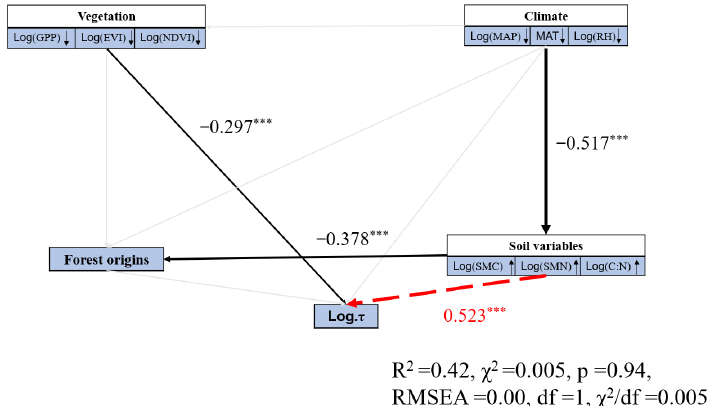
Figure A10. The main influencing factors of C turnover in the subsoil of DNF were obtained by the SEM model. The symbols “ ↑ ” and “ ↓ ” indicate a positive or negative correlation between environmental factors and subsoil τ . The goodness of fit statistics for the effect size model of the relationship are as follows: *** p < 0.001.